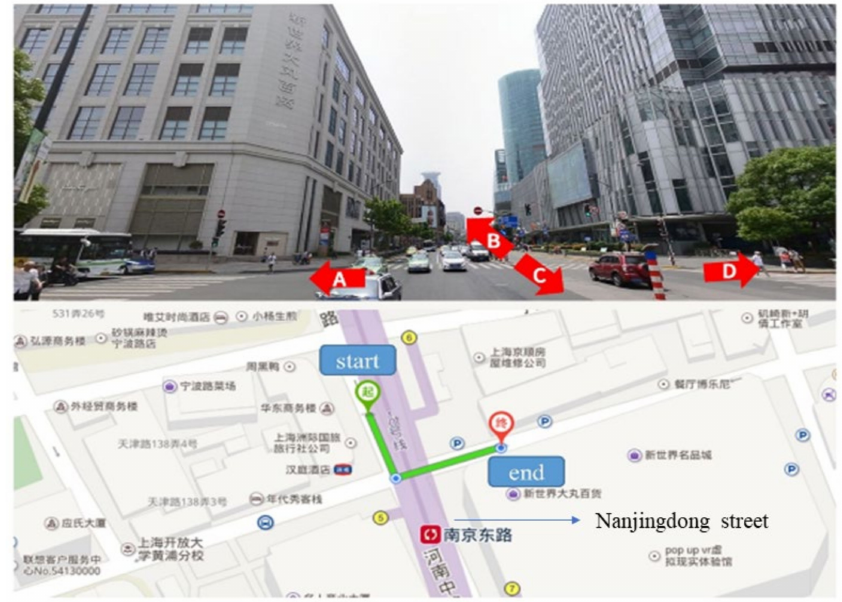
Figure 1. An example task showing a street view scene ( upper ) and a map ( lower